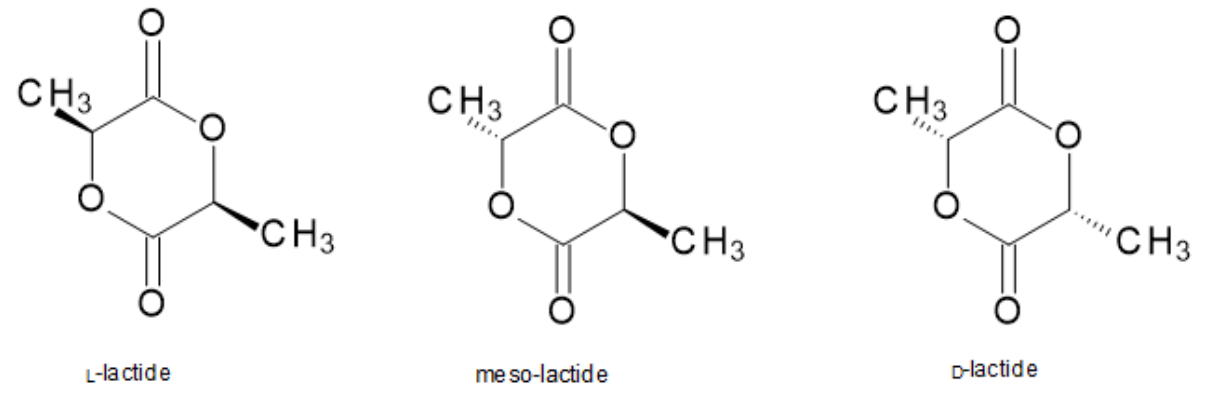
Figure 8. Lactide—cyclic dimers for the ROP process [7].